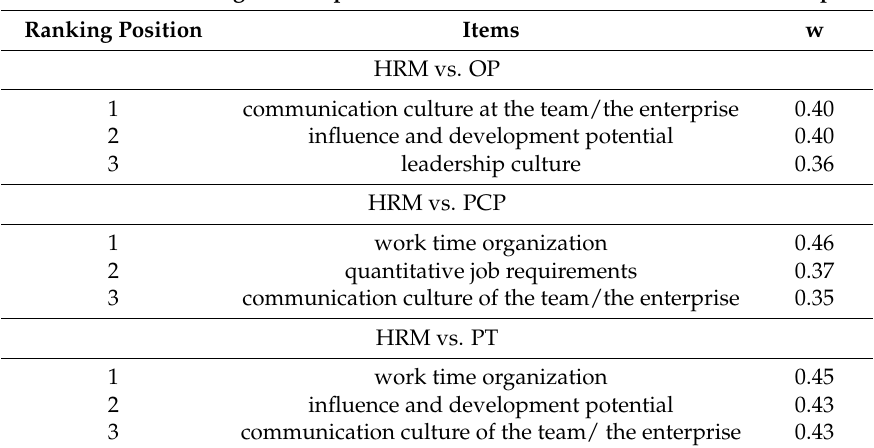
Table 6. Largest group differences between HRM and the three medical professions. Factors with the Largest Group Differences between HRM and Medical Groups Ranking Position